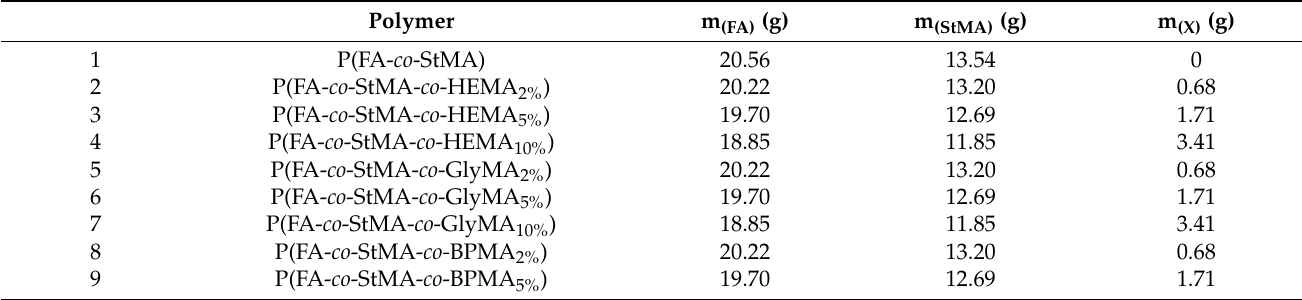
Figure 1. ( a ) Reaction scheme of the starved feed emulsion polymerization of fluoroacrylate (FA), stearyl methacrylate (StMA), and the cross-linking agent X, ( b ) shows the cross-linking reagents hydroxyethyl meth acrylate (HEMA), glycidyl methacrylate (GlyMA), and 3-hydroxy benzophenone methacrylate(BPMA). Table 1. List of the polymers synthesized with FA, StMA, and the cross-linking reagent X (HEMA, GlyMA, BPMA) with all masses of monomers used.